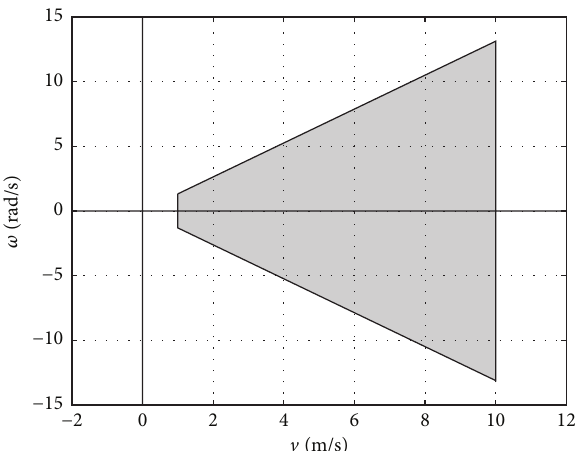
Figure 4: Graphical representation of viable control envelope